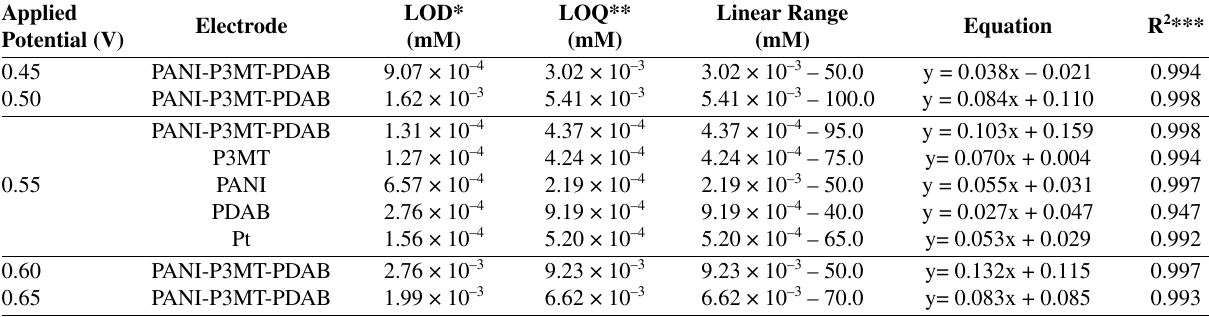
Table 1. Comparison of analytical parameters over uncoated and coated Pt electrodes for the determination of HQ.